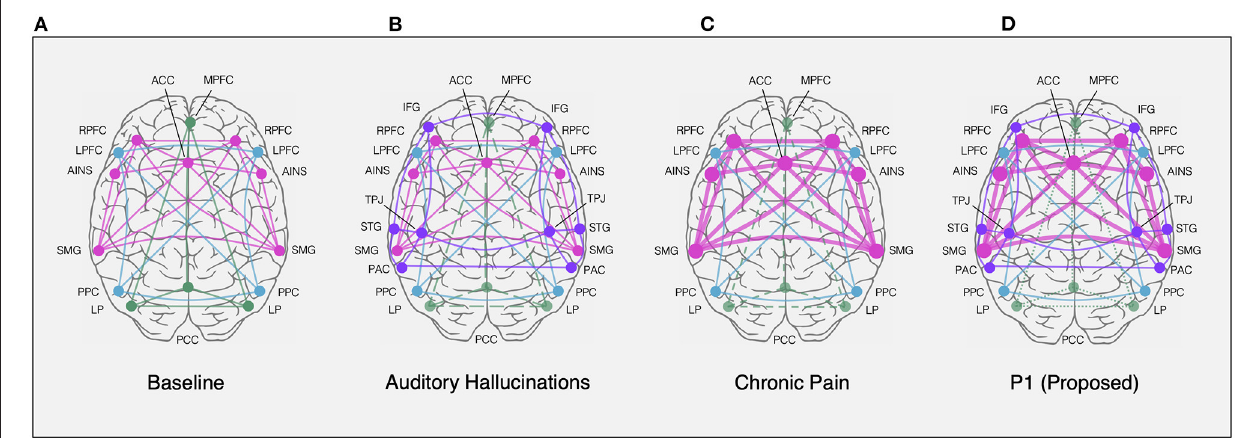
FIGURE 4 | Resting-state network nodes (circles) and connections (lines) depicting the salience network (SN, pink ), default mode network (DMN, green ), central executive network (CEN, blue ), and activated sensorimotor areas ( purple ). Networks are superimposed on axial view of cortical surface from above (anterior towards the top). (A) Normal resting connectivity represented in healthy controls ( 73, 74). (B) Resting state activation of sensorimotor areas, including IFG, STG, PAC, and TPJ, in response to DMN withdrawal (i.e., decrease, dashed lines) in auditory hallucinators (75–78). (C) Resting state increase in SN connectivity and decrease in DMN connectivity among chronic pain patients (79, 80). (D) Proposed combination of chronic pain and hallucinatory network states in response to ACC stimulation demonstrated by DMN withdrawal, sensorimotor shift, and SN hyperactivation, based on previous models (74–77, 79). ACC, anterior cingulate cortex; AINS, anterior insular cortex; IFG, inferior frontal gyrus; LP, lateral parietal cortex; LPFC, lateral prefrontal cortex; MPFC, medial prefrontal cortex; PAC, primary auditory cortex; PCC, posterior parietal cortex; PPC, precuneus cortex; RPFC, rostral prefrontal cortex; SMG, supramarginal gyrus; STG, superior temporal gyrus; TPJ, temporoparietal